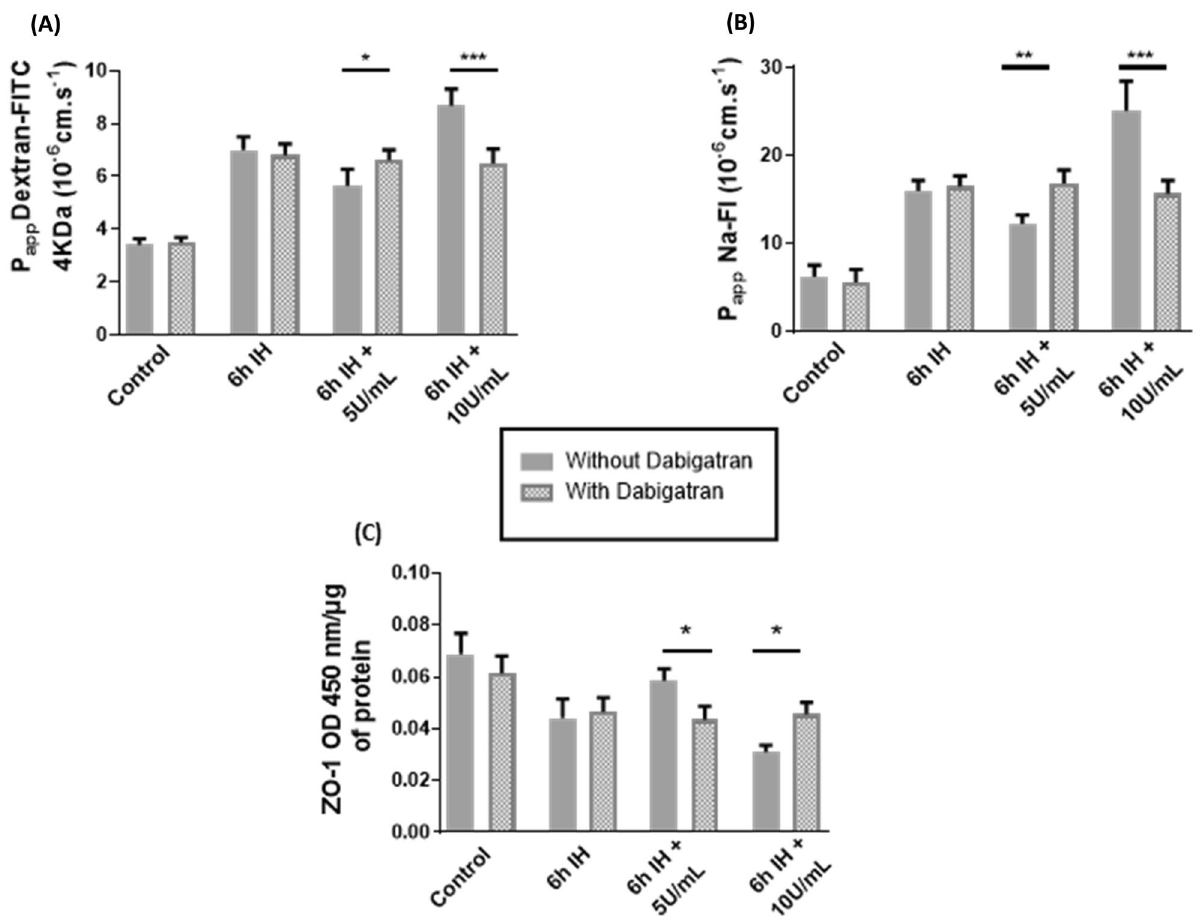
Figure 6. Apparent permeability (Papp) for FITC-dextran ( a ) or Na–Fl ( b ) and expressions of ZO-1 ( c ) after pretreatment with dabigatran in our cycles of IH with or without thrombin at 5U/mL and 10U/mL. Results are represented as mean value ± SD ( n = 9, N = 3), * p ≤ 0.05, ** p ≤ 0.01, *** p ≤ 0.001. IH intermittent